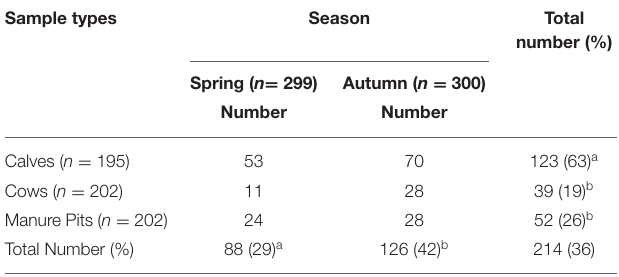
TABLE 4 | Number of positive samples with a presumptive ESBL/AmpC Eschericha coli isolated from calf or cow feces or manure pit of 101 dairy farms in Québec